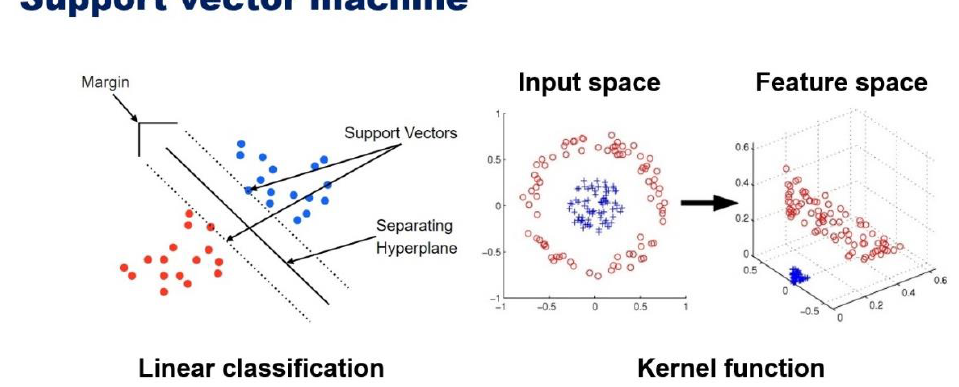
Figure 4. Decision boundary function of SVM algorithm.